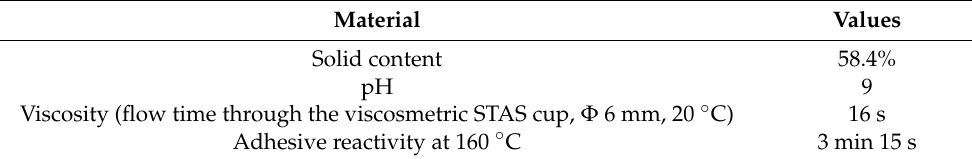
Table 3. Characteristics of the oxidized magnesium lignosulfonate